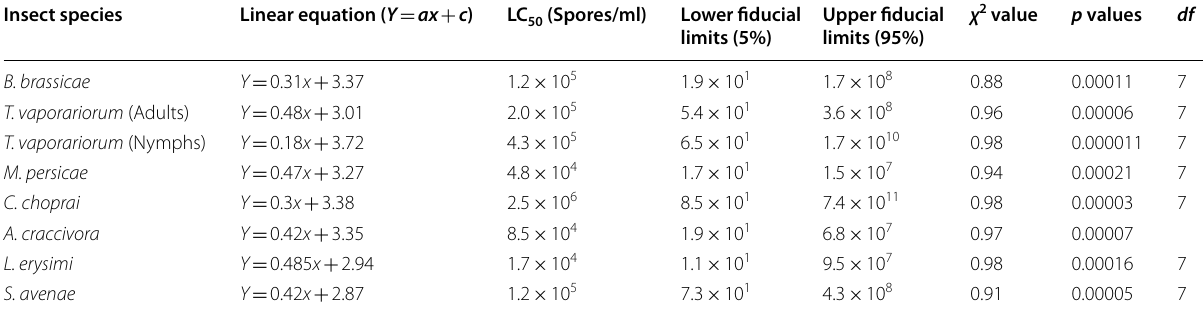
Table 2 Lethal concentrations of A. alternata VLH1 against major sucking pests of hill agriculture Insect species Linear equation ( Y